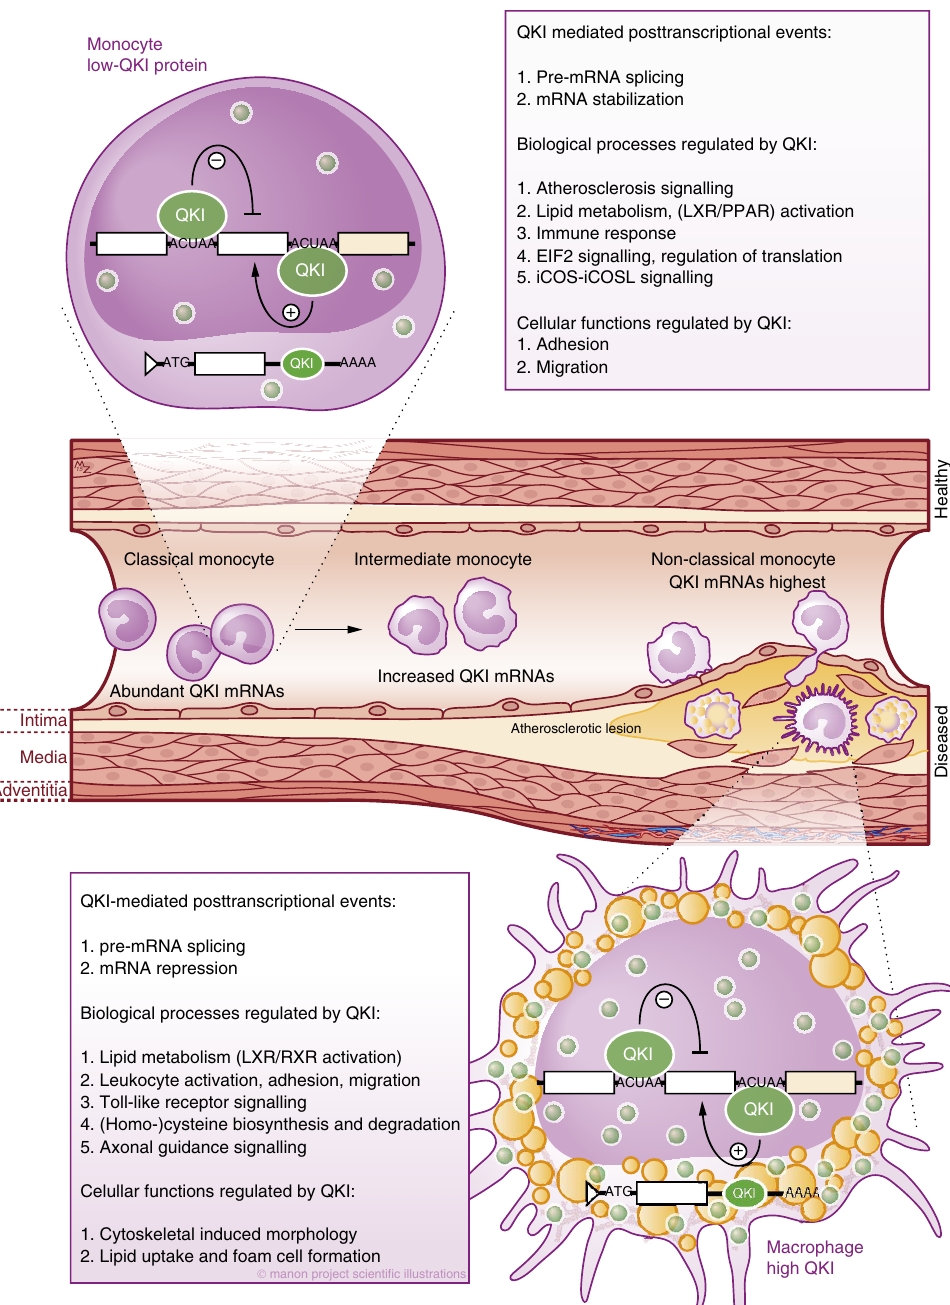
Figure 9 | Schematic depicting how QKI posttranscriptionally regulates monocyte to macrophage differentiation and atherosclerosis development. QKI mRNA expression increases in intermediate monocytes, reaching a peak in the non-classical monocyte (middle). Monocytes adhere to the endothelium at sites of tissue injury, leading to their activation and migration into the subendothelial space. This process requires QKI, as the targeted ablation of QKI impaired monocyte adhesion and migration, and the evident transition in cellular phenotype requires extensive reprogramming of the posttranscriptional landscape. On tissue entrance, the monocyte differentiates into a macrophage, a conversion that was associated with a potent increase in QKI protein. This increase potentiates the interaction of QKI with (pre-)mRNA targets, enhancing splicing and target mRNA repression. The loss of QKI in macrophages results in an inability to adopt the macrophage phenotype and a perturbation of lipid uptake and foam cell